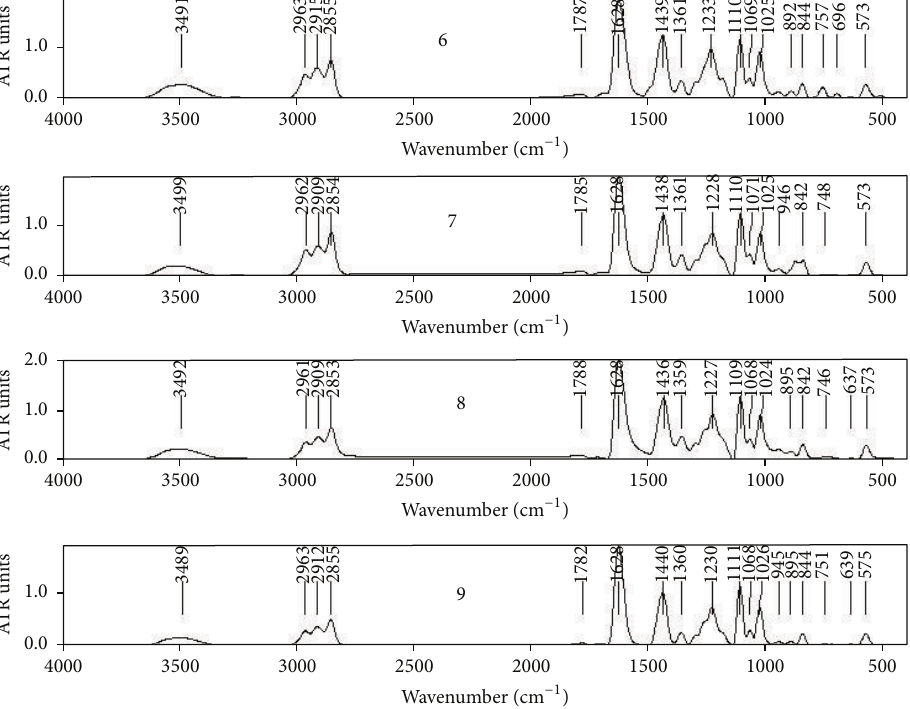
Figure 3: FT-IR spectra of poly(NAM) synthesized in different solvents by radical polymerization: 6 in anisole, 7 in 1,4-dioxane, 8 in toluene, and 9 in THF.